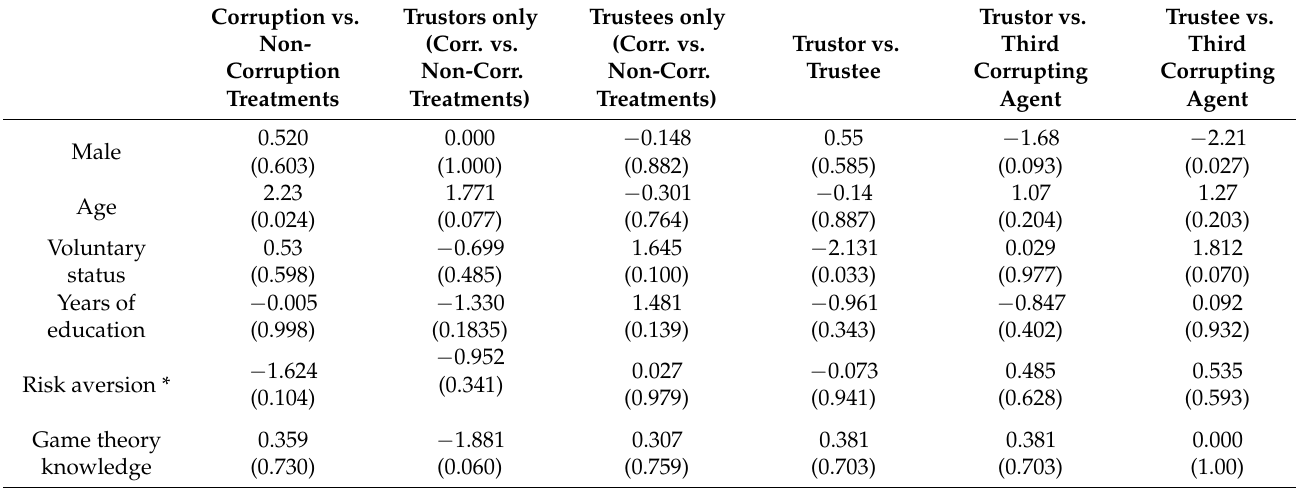
Table 1. Balancing properties (between corruption/non-corruption treatments and players’ roles)–z-stat (with p -values in